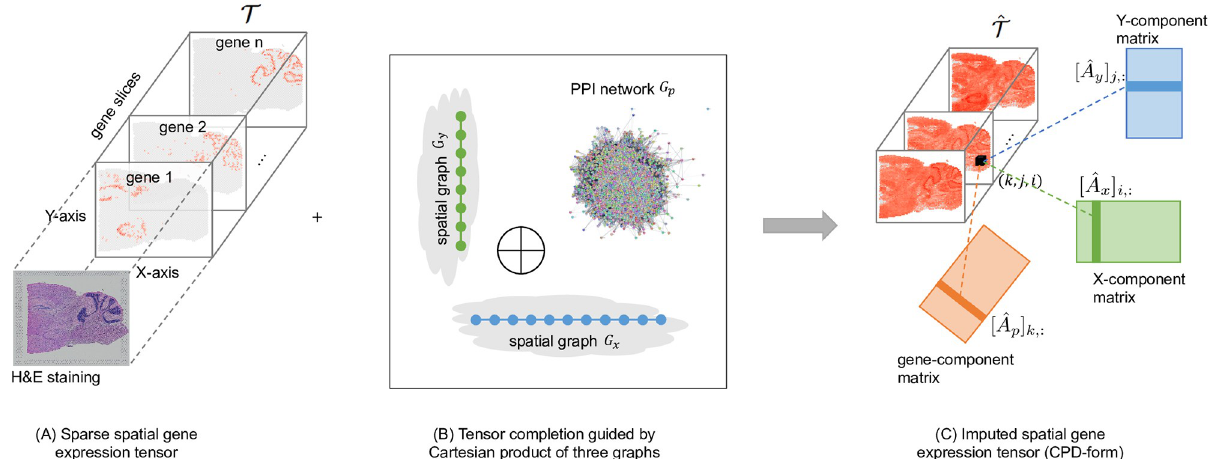
Fig 1. Imputation of spatial transcriptomes by graph-regularized tensor completion. (A) The input sptRNA-seq data is modeled by a 3-way sparse tensor in genes ( p -mode) and the ( x , y ) spatial coordinates ( x -mode and y -mode) of the observed gene expressions. H&E image is also shown to visualize the cell morphologies aligned to the spots. (B) A protein-protein interaction network and a spatial graph are integrated as a product graph for tensor completion. The spatial graph is also a product graph of two chain graphs for columns ( x -mode) and rows ( y -mode) in the grid. (C) After the imputation, the CPD form of the complete tensor can be used to impute any missing gene expressions, e.g. the entry ( k , j , i ) can be reconstructed as the sum of the element-wise multiplications of the three components ½ ^ A